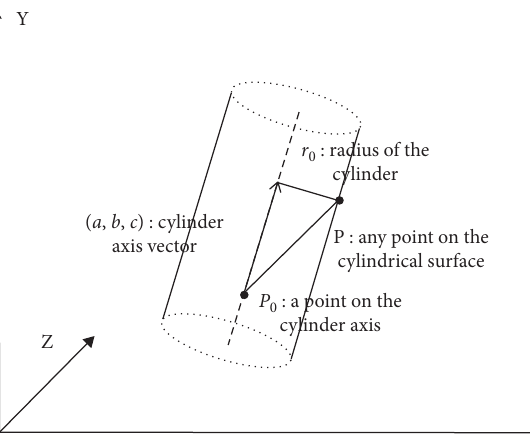
Figure 7: Geometric characteristics of the cylindrical surface.